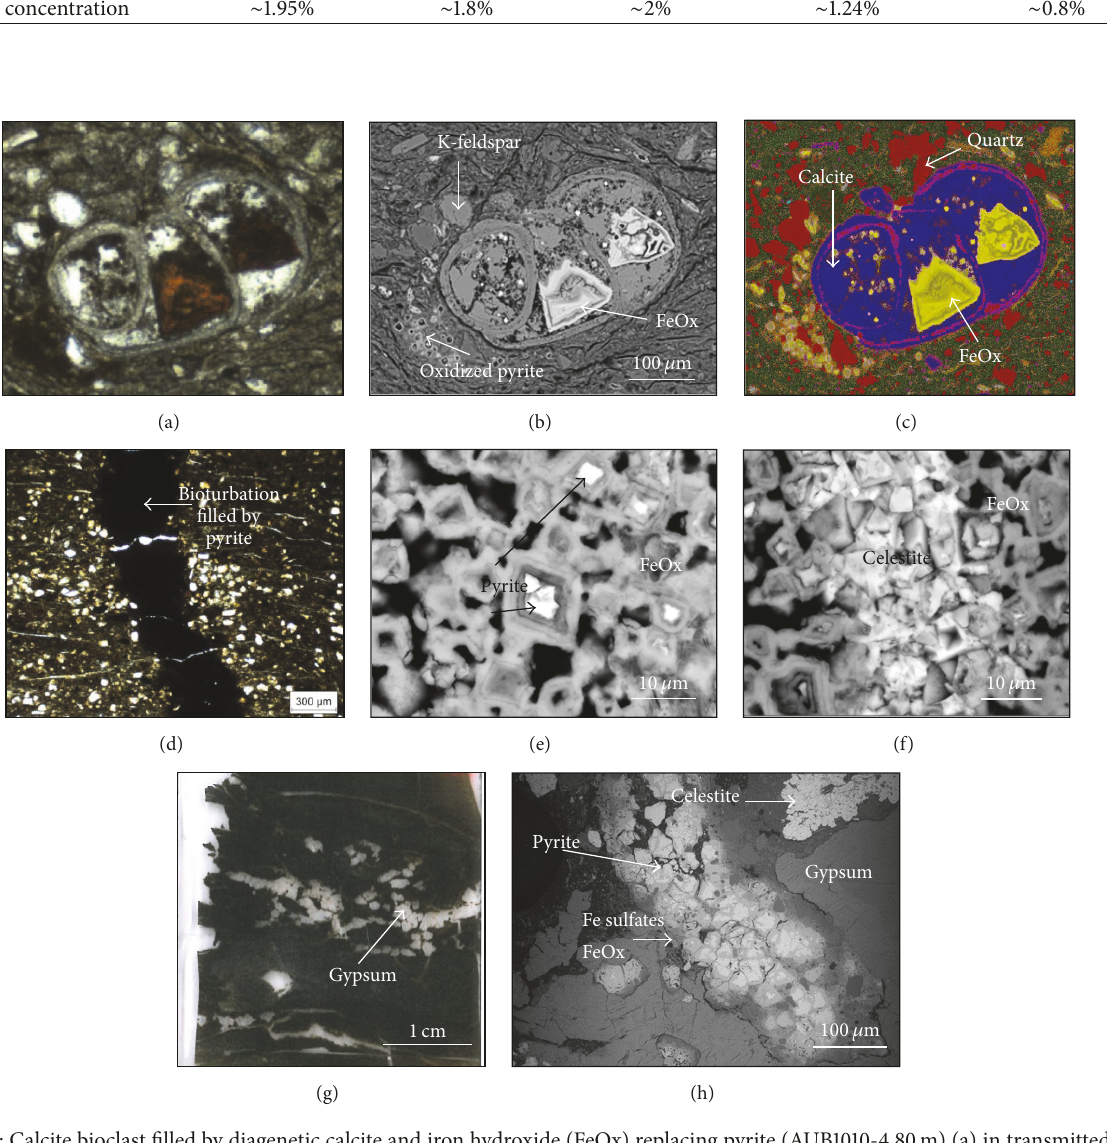
Figure 5: Calcite bioclast filled by diagenetic calcite and iron hydroxide (FeOx) replacing pyrite (AUB1010-4.80 m) (a) in transmitted light; (b) in BSE and (c) in chemical composite image (blue: Ca-rich, yellow: Fe rich; red: Si-rich); (d) bioturbation filled by pyrite (AUB1010-6.63 m) (transmitted light); (e) detail of pyrite partially replaced by iron hydroxides (BSE); (f) celestite partially filling zone of pyrite oxidation (BSE); (g) distribution of millimetric gypsum grains replacing pyrite layer in AUB1010-8.25 m (photo of the glass slide); (h) residual diagenetic pyrite and celestite surrounded by secondary iron sulfates, iron hydroxides, and